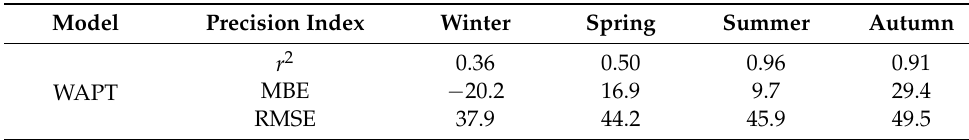
Table 4. Statistics of the modeling LE accuracies in four seasons during 2013–2018, with summer from June to August, autumn from September to November, winter from December to February, and spring from March to May.